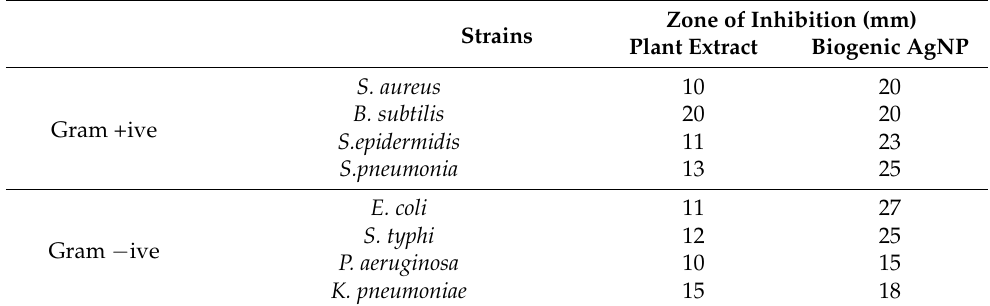
Table 3. Zone of inhibition (mm) of AgNPs synthesized from plant extract against different gram +ive and gram − ive bacterial